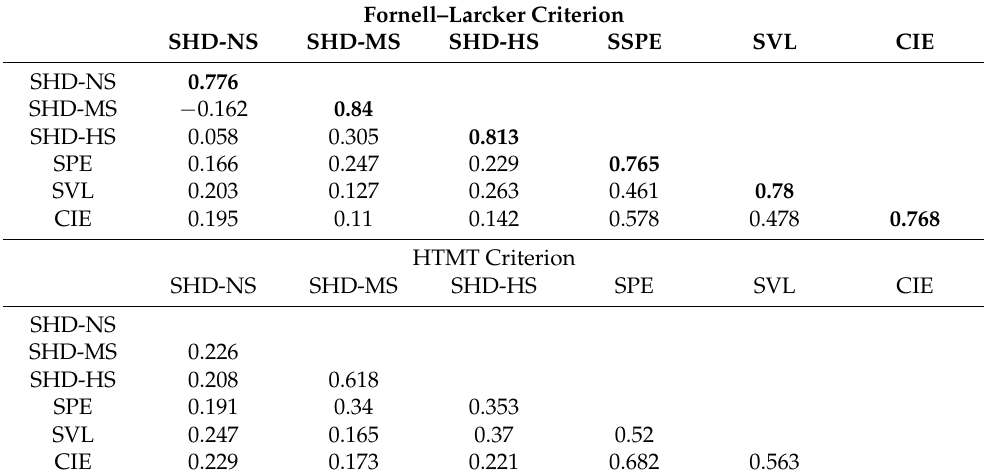
Table 5. The test of discrimination validity of the variables, SHD-NS: harmonious degree of natural sound, SHD-MS: harmonious degree of mechanical sound, SHD-HS: harmonious degree of human sound, SPE: soundscape perception, SVL: satisfaction degree of visual landscape, CIE: comprehensive impression evaluation. Fornell–Larcker Criterion